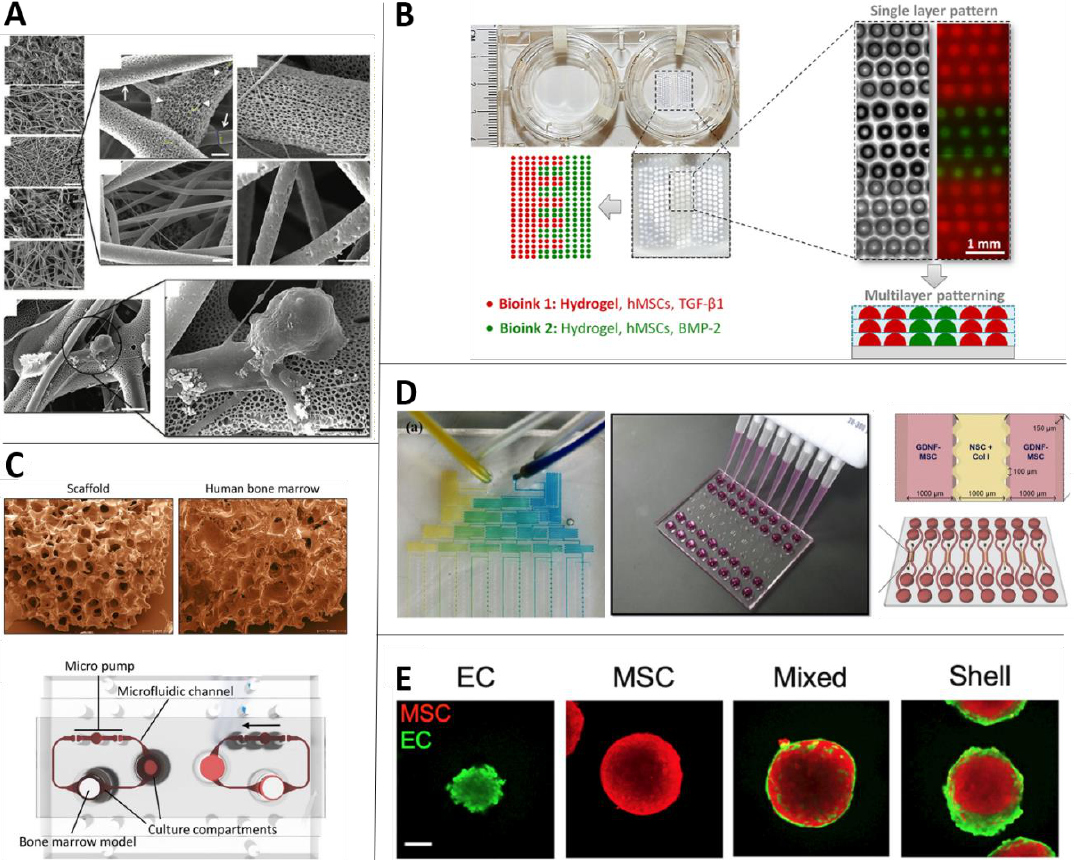
Figure 3. Novel in vitro technologies using MSCs. ( A ) Differentiation of MSCs towards neurons using scaffolds, with different PLA concentrations (adapted from Reference [37]). ( B ) 3D bioprinted MSC patterns in hydrogels (adapted from Reference [109]). ( C ) MSCs in bone marrow scaffolds on OoC (adapted from Reference [110]). ( D ) left: Microfluidic platform to serially dilute morphogens for MSC culture units (adapted from Reference [111]); right: Microfluidic solution for co-culture of MSCs and NSCs to mimic paracrine signaling (adapted from Reference [112]). ( E ) Spatial localization of MSCs and ECs in spheroid co-cultures (adapted from Reference [113]).